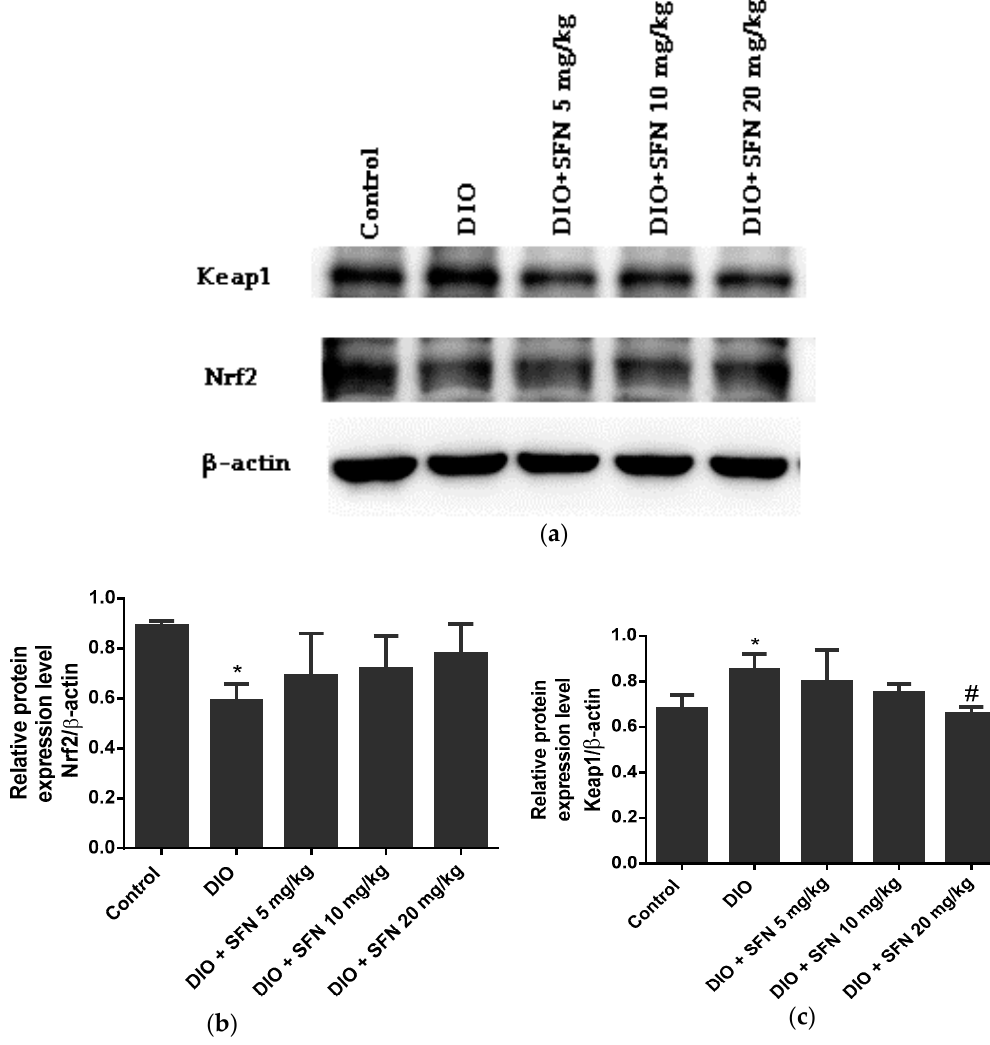
Figure 6. E ff ects of SFN on the protein expression related to oxidative stress in obese mice: ( a ) Protein expression of Nrf2 and Keap1. β -actin was used as a protein control to normalize the volume of protein expression: ( b , c ) Semiquantitative measurement of Nrf2 and Keap1. Data are expressed as mean ± Standard Error (SE). n = 3. * p < 0.05 vs. the control